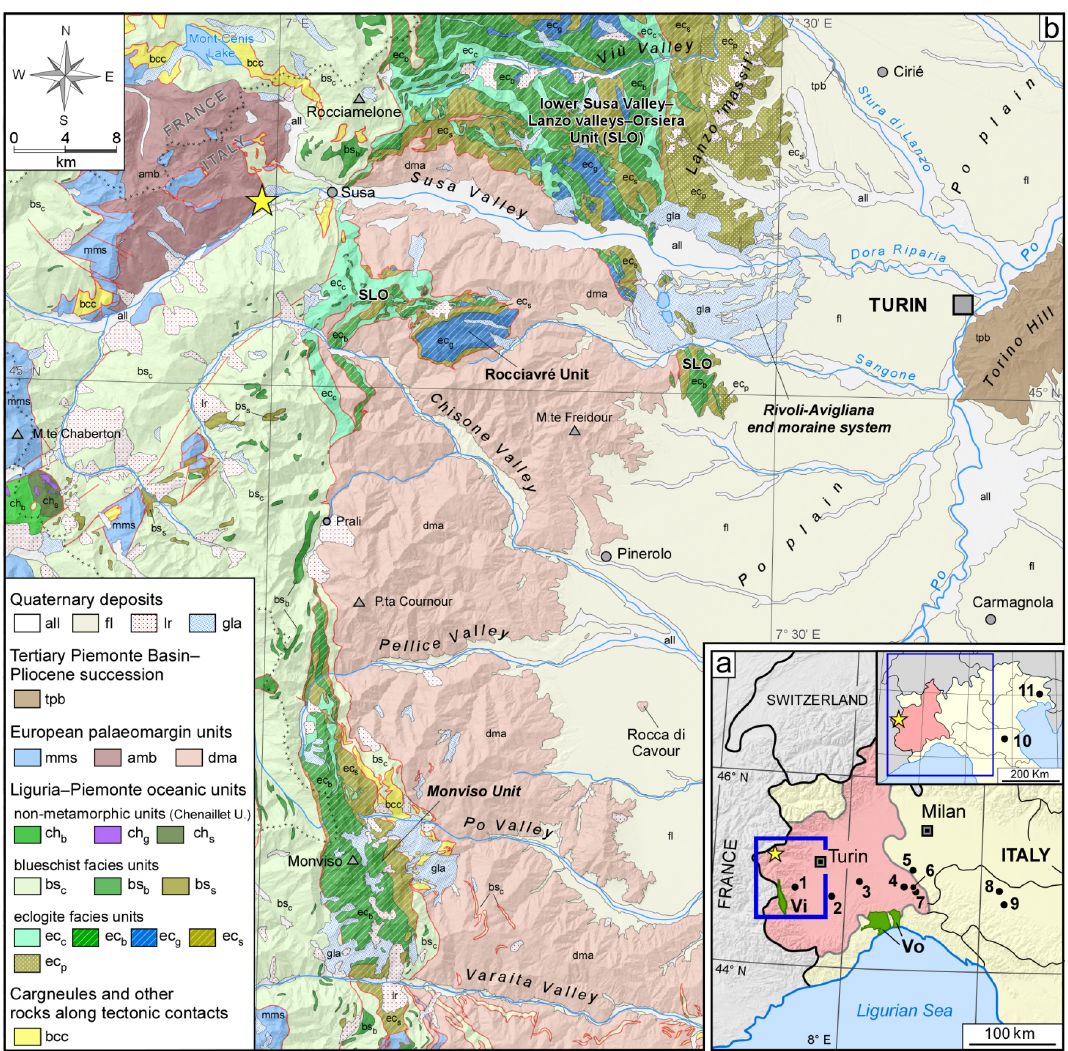
Figure 1. (a) Map of northwestern Italy showing the position of the Chiomonte archaeological site (star) and of the other coeval archaeolog- ical sites cited in the text (1 – Rocca di Cavour; 2 – Alba; 3 – Castello di Annone; 4 – Villaromagnano; 5 – Rivanazzano; 6 – Momperone; 7 – Brignano Frascata; 8 – Gaione; 9 – Ponte Ghiara). The position of the Monviso (Vi) and Voltri (Vo) massifs is also shown. The blue rectangle indicates the area of the geological map in (b) . The inset shows a simplified map of northern Italy, with an indication of the sites of Chiomonte (star), San Lazzaro di Savena (10) and Sammardenchia (11). (b) Simplified geological map of the Italian side of Cottian and southern Graian Alps (from the Varaita Valley to Viù Valley), showing the position of the archaeological site of Chiomonte (star) and the distribution of the geological units, here considered possible sources for the supply of raw materials (eclogite facies meta-ophiolites of the Liguria–Piemonte oceanic units and alluvial and glacial deposits). Geological boundaries redrawn from Piana et al. (2017) (Italian area), Kerckhove et al. (1980) (French area south of 45 ◦ N) and Debelmas (1980) (French area north of 45 ◦ N). Quaternary deposits: all – alluvial deposits (Holocene–Present); fl – terraced alluvial and fluvioglacial deposits (Pleistocene–Holocene); lr – landslide, block stream, and rock glacier deposits; gla – glacial deposits. Tertiary Piemonte Basin and Pliocene succession – tpb. European palaeomargin units: Mesozoic meta-sedimentary units – mms; Ambin massif – amb; Dora–Maira unit (pre-Triassic basement rocks and associated meta-sedimentary cover) – dma. Liguria–Piemonte oceanic units: non-metamorphic units (Chenaillet unit; basalt – ch b ; gabbro – ch g ; serpentinite and serpentinite breccia – ch s ); blueschist facies units (calc-schist – bs c , with local gneiss intercalations; metabasite – bs b ; serpentinite – bs s ); eclogite facies units (Monviso, Rocciavré, lower Susa Valley–Lanzo valley–Orsiera unit, SLO; calc-schist – ec c ; metabasite – ec b ; metagabbro – ec g ; ser- pentinite – ec s ; peridotite of the Lanzo ultramafic massif – ec p ). Cargneules and metasedimentary rocks: main bodies of cargneules – bcc, evaporites and metasedimentary rocks preserved along tectonic